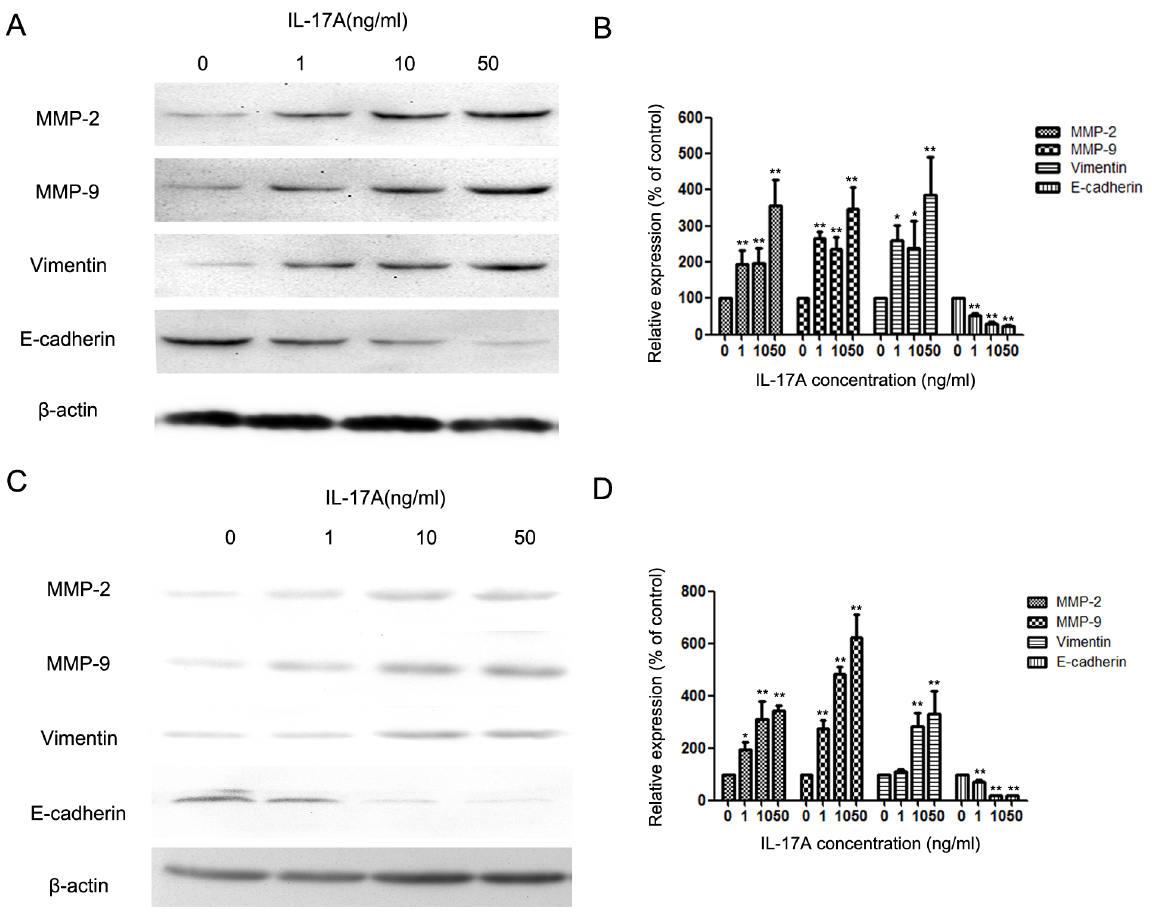
Figure 2. IL-17A promotes the expressions of MMP-/-9 and Vimentin suppresses the expressions of E-cadherin in NPC-039 and CNE-2Z cells. (A) Expressions of MMP-2/-9, Vimentin and E-cadherin in NPC-039 cells were compared by western blotting between cells treated with different concentrations of IL-17A (0, 1, 10 and 50 ng/ml) for 24 hours. (B) Quantification of the protein levels of MMP-2/-9, Vimentin and E-cadherin in NPC-039 cells. (C) Expressions of MMP-2/-9, Vimentin and E-cadherin in CNE-2Z cells were compared by western blotting between cells treated with different concentrations of IL-17A (0, 1, 10 and 50 ng/ml) for 24 hours. (D) Quantification of the protein levels of MMP-2/-9, Vimentin and E- cadherin in CNE-2Z cells. Values represent the means 6 SD of three independent experiments performed in triplicate. * p , 0.05 and ** p , 0.01 compared with the control group.